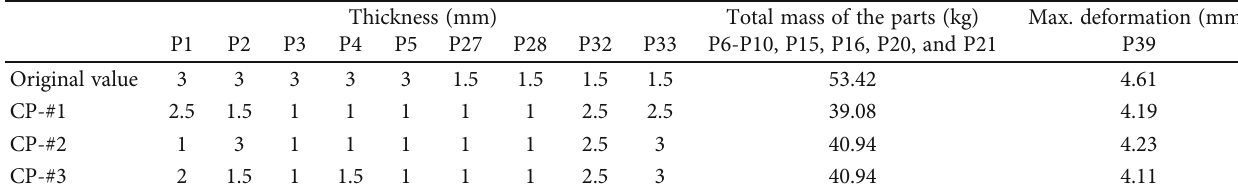
Table 7: Candidate points (CP) obtained from RSO.